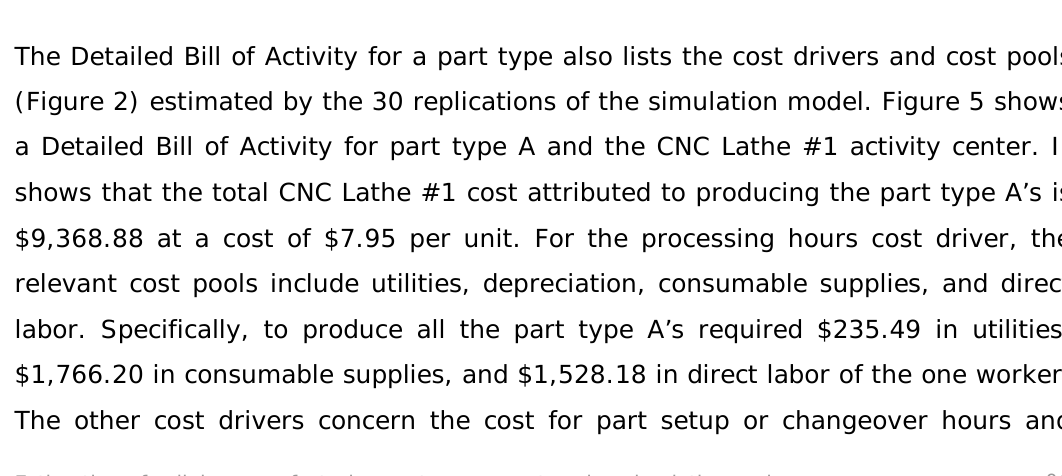
Figure 5. “Detailed bill of activity for part type a showing CNC lathe #1 activity